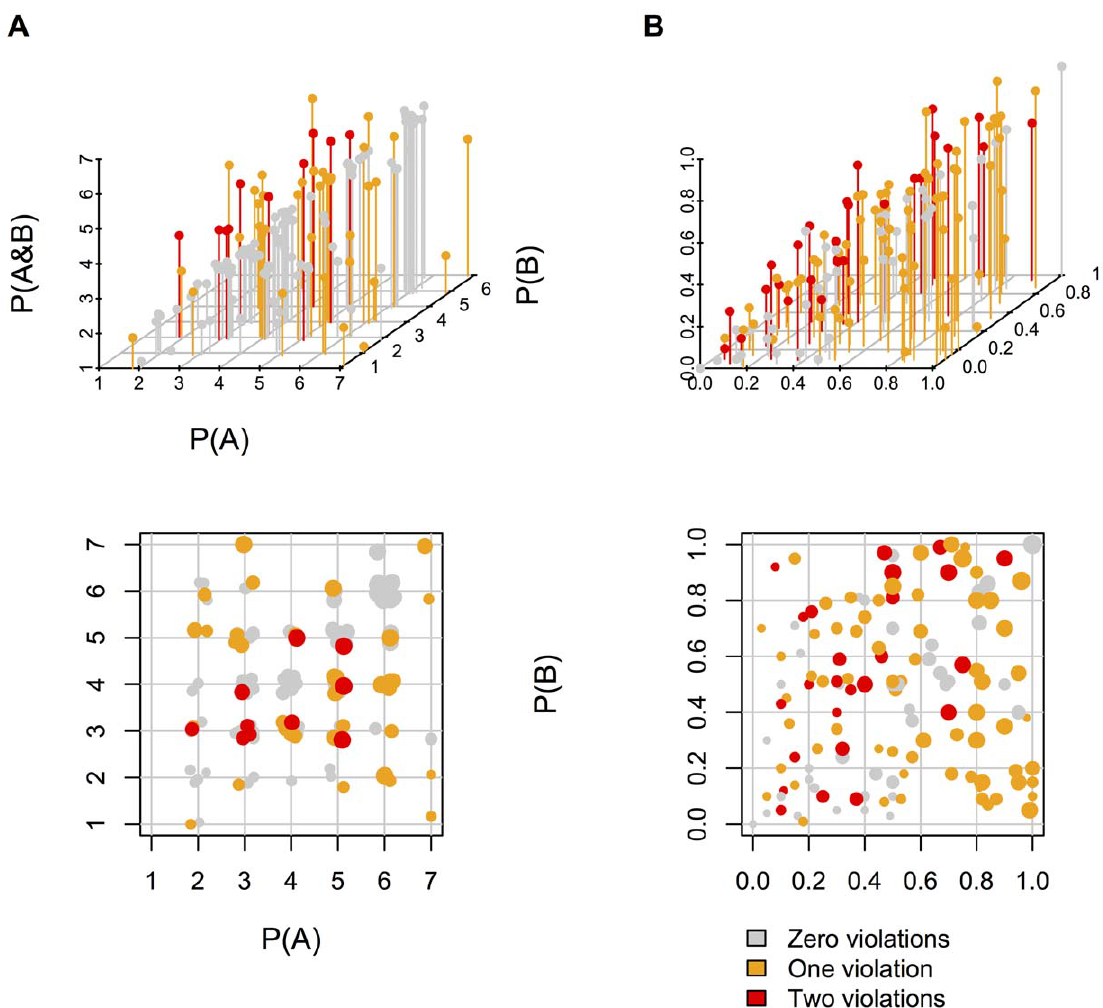
Figure 2. 3D scatterplots of estimates of P( A ), P( B ), and P( A&B ) and 2D scatterplots of verbal scale (Panel A) and numerical scale (Panel B) estimates of P( A ) and P( B ) in Experiment 2 (see Figure 1 for an explanation of zero, one, or two violations). Participants’ estimates were separated by whether the estimate reflected zero, one, or two violations of the JPD. A violation was defined as a negative probability in the JPD extrapolated from the estimates. In the 2D scatterplots, estimates of P( A&B ) correspond to the size of points such that larger points indicate larger estimates.